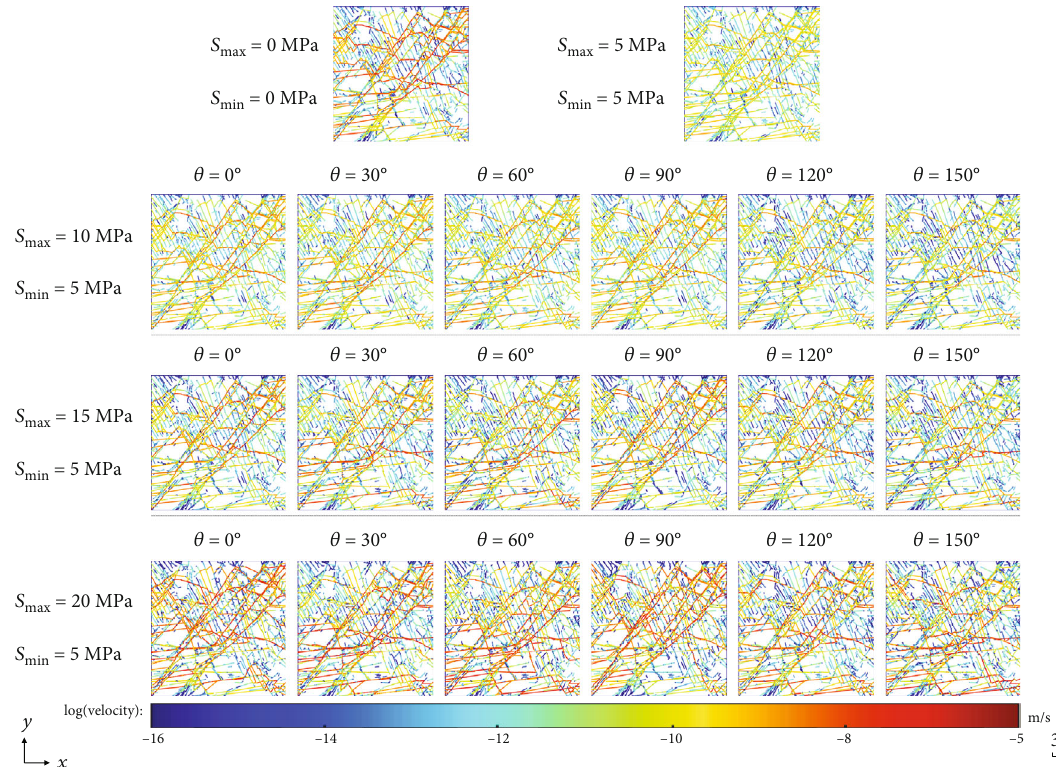
Figure 5: Distributions of fl ow velocity in the fracture network under di ff erent stress